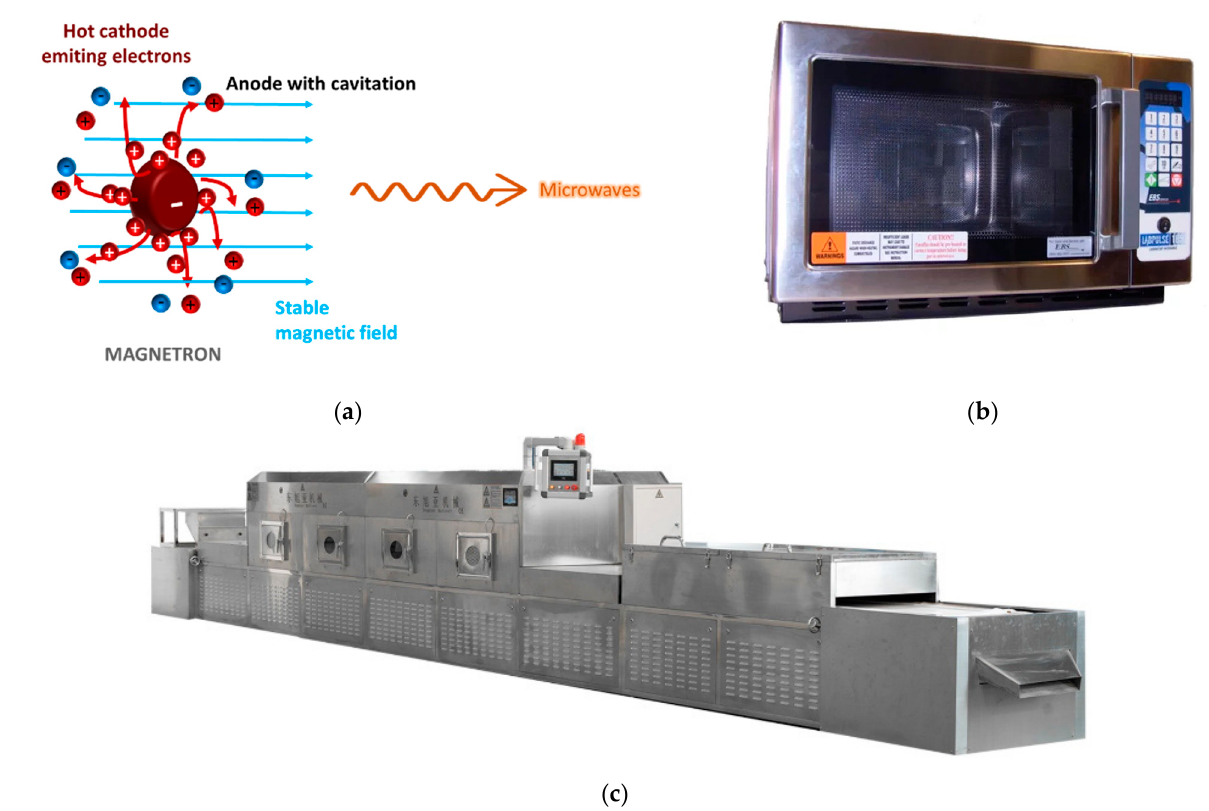
Figure 8. ( a ) Simplified scheme of the microwaves formation by magnetron; ( b ) picture of a microwave instrument designed for lab work Labpulse ® ; ( c ) picture of Large-scale microwave chain Xujia™ .